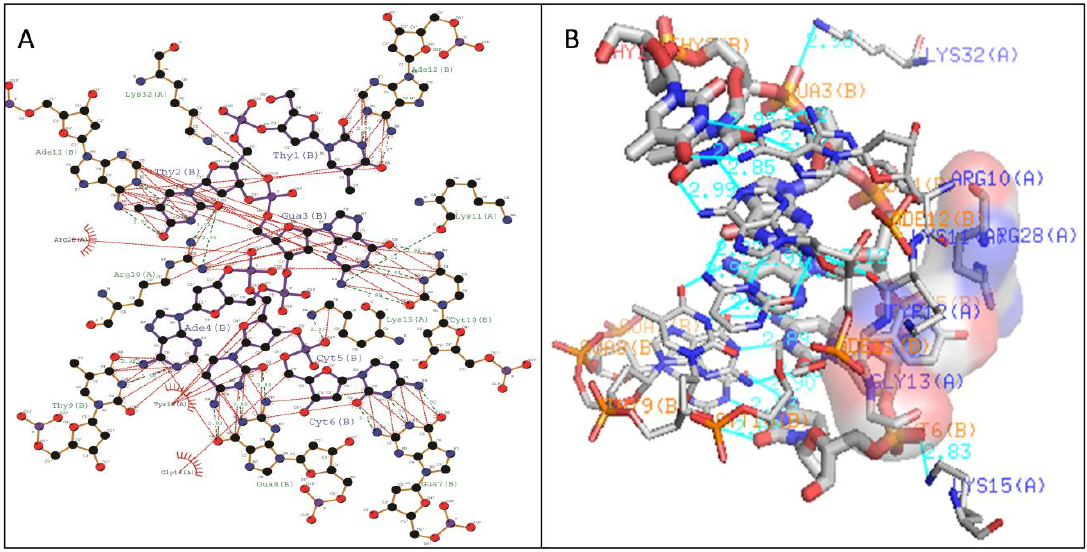
Figure 9. Illustration of ( A ) Two-dimensional and ( B ) 3-dimensional representation of the Type III WRKY protein DNA docked complex. Hydrogen bond interaction of DNA with WRKY protein amino acid residues, Lys16, Arg22, Tyr24 and Lys35 (shown by the green line) whereas residues Lys11, Tyr12, Lys15, Arg33, and Tyr36 interacts through hydrophobic bonding (shown in red lines).